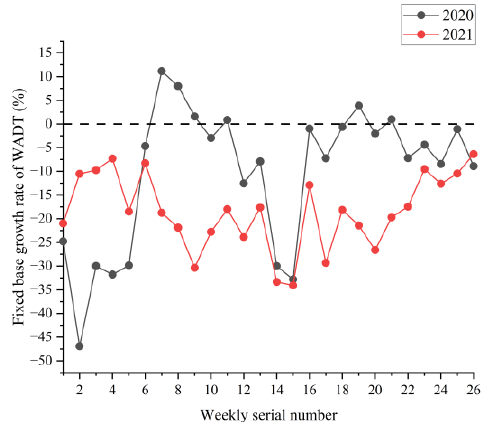
Figure 4. WTCT. Figure 4. WTCT.